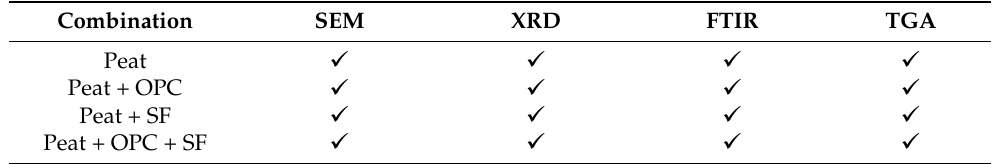
Table 4. Microstructural testing matrix.